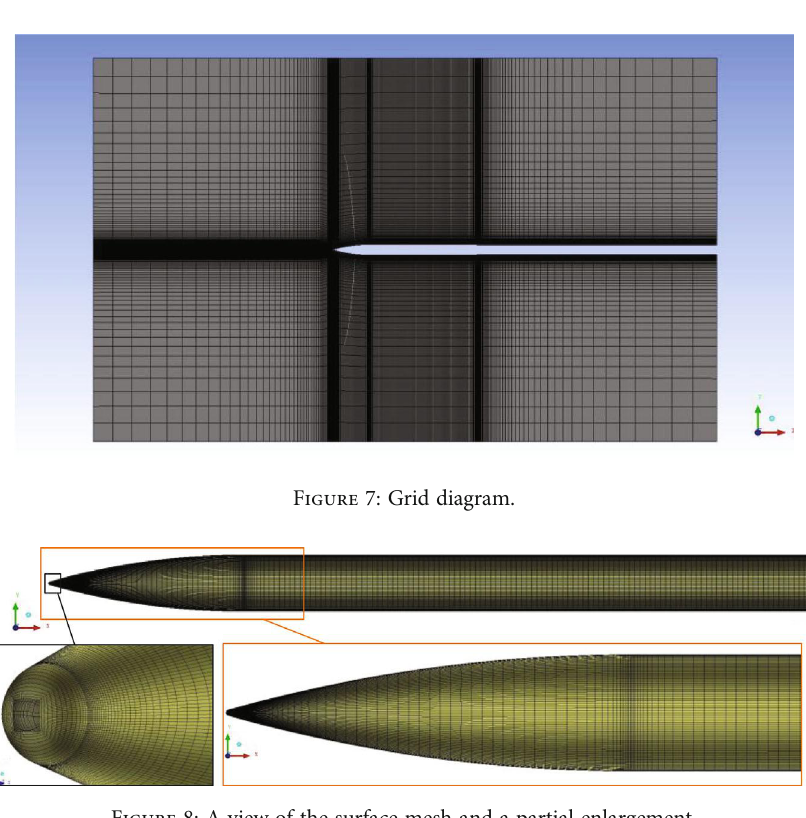
Figure 8: A view of the surface mesh and a partial enlargement.